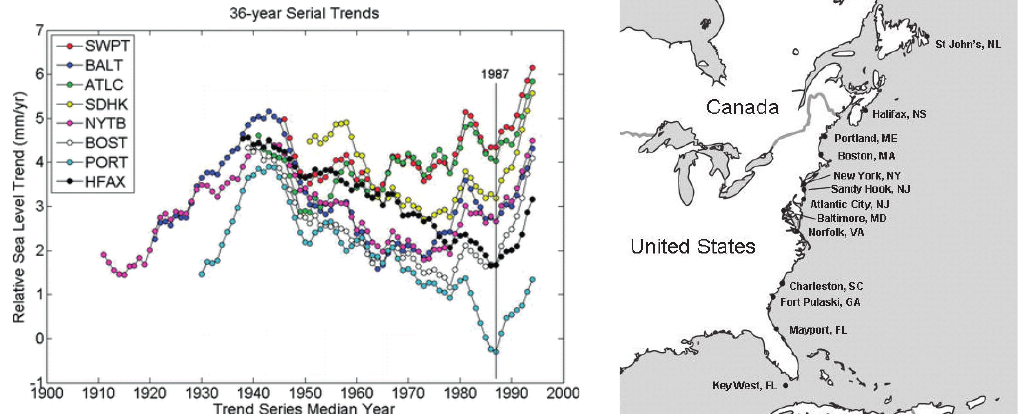
Fig. 2. Time hystories of the sea level rises computed by linear fitting of 36 years of data in different locations of teh western Atlantlantic (from [2]). The linearly increasing rates of sea level rise are claimed to infer a constant acceleration confirmed by applying quadratic regres- sion analysis to the 1969 – 2011 mean sea level series. The results support the claim that sea level rise is now locally accelerating at rates as high as 0.30 mm/y 2